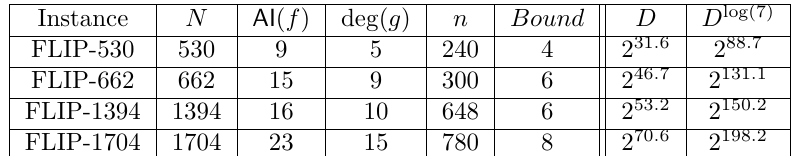
Table 4: Lower bounds on AI k of FLIP instances and complexity of the algebraic attack, N refers to the number of variables, AI ( f ) is equal to the degree of f , n is the number of variables in f , and the lower bound is given with theorem 1. f is the Boolean function defined by the direct sum of all the monomials of degree strictly greater than deg( g ) and g takes all monomials of degree less or equal to deg( g ), D refers to the number of variables after linearization and D log(7) to the corresponding attack